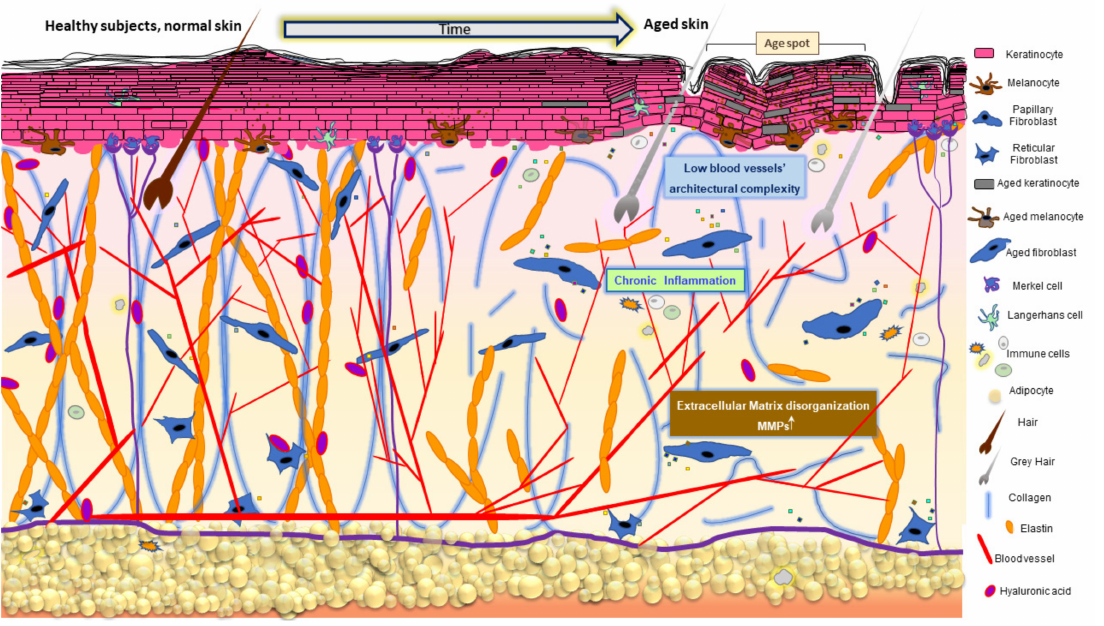
Figure 2. Age-related changes in the skin. Skin aging results in cumulative detrimental effects charac- terized by abnormal ECM organization, pigmentary changes, loss of subcutaneous fat, hair greying, minored hair density, decreased sebaceous gland function, and low-grade chronic inflammation. Cellular and molecular events reviewed in the text describe the impact of oxidative disequilibrium on these time-dependent and/or extrinsically accelerated tissue